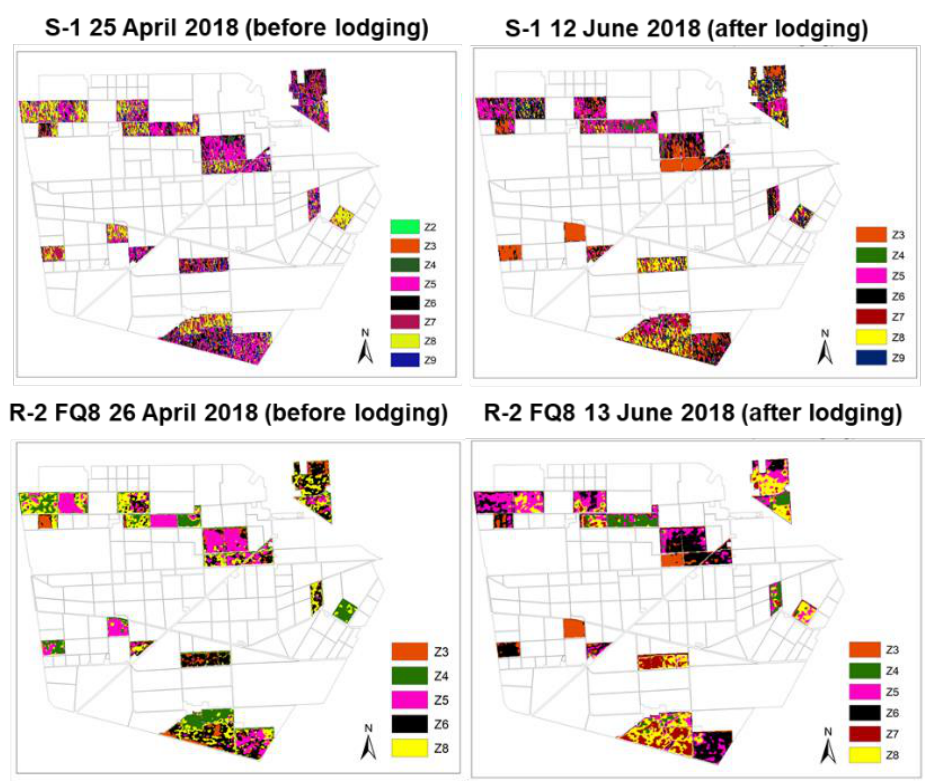
Figure 4. Combined H/α and Wishart unsupervised classification of scattering mechanisms from before and after lodging image pairs derived using near date Sentinel-1 (25 April, 12 June) and low incidence angle RADARSAT-2 FQ8 (26 April, 13 June) data. “RADARSAT-2 Data and Products. MacDonald, Dettwiler and Associates Ltd. (2018) – All Rights Reserved. RADARSAT is an official trademark of the Canadian Space